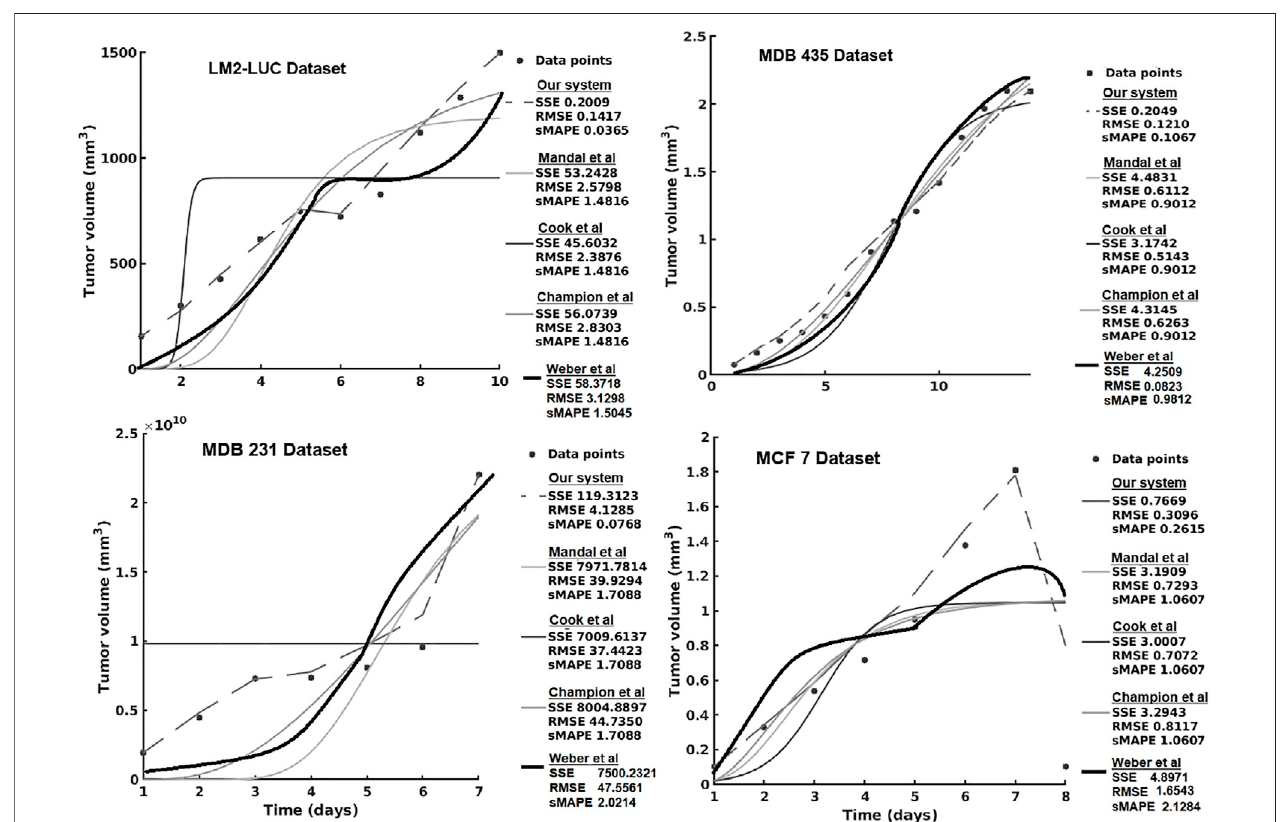
FIGURE 7 | Evaluation of the data-driven relation learning system on perturbed tumor growth: accuracy evaluation. The decrease in the MCF7 dataset is due to a high-dose chemotherapy administration and demonstrates the adaptivity of the methods to cope such abnormal growth behaviors.